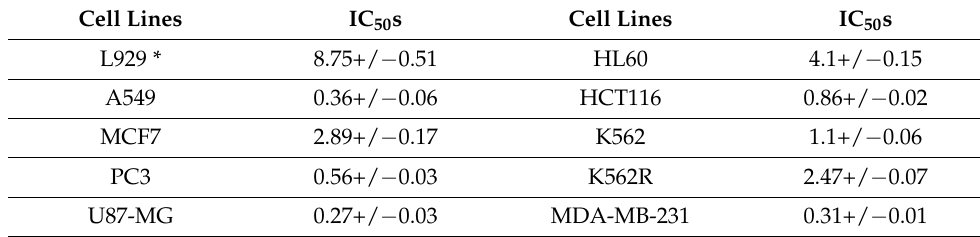
Table 3. Antiproliferative activities of T2G2.HCl